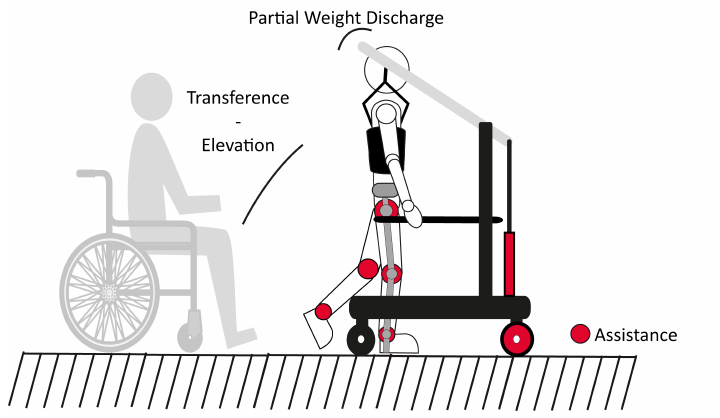
Figure 1. General view of the HYBRID